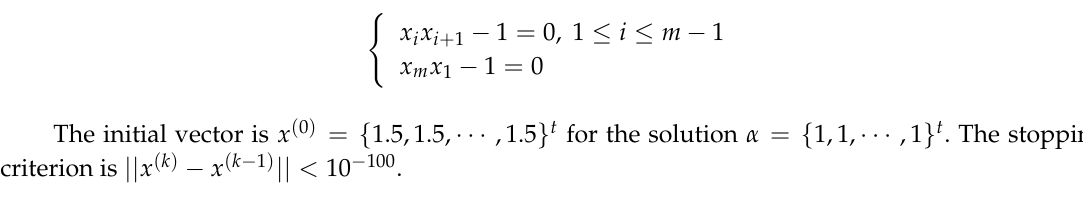
Table 5. Performance of methods for Example 3, where ( m , µ ) = ( 199, 1 ) .